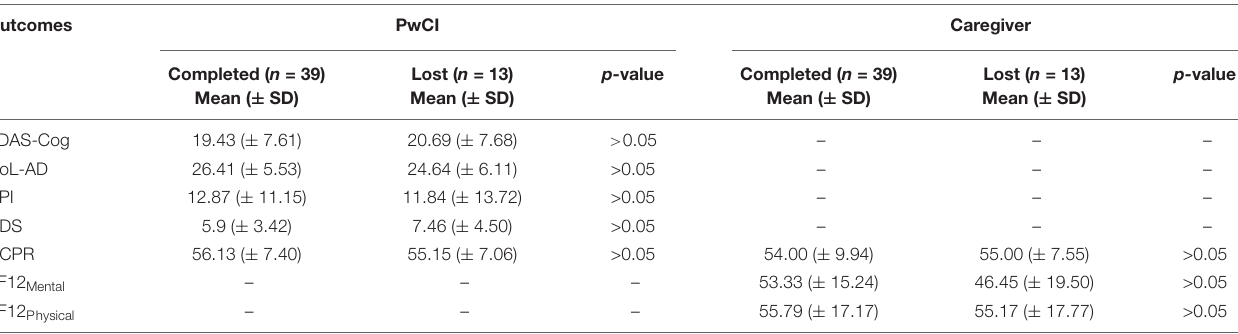
TABLE 2 | Clinical outcomes of PwCI and caregiver by lost and